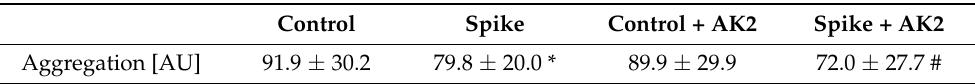
Data are shown as mean ± SD, n = 7. The spike protein significantly reduced platelet aggregation in control sample (* p < 0.05; spike vs. control) and in blood preincubated with anti-GPIb (AK2) antibodies (# p < 0.01; spike